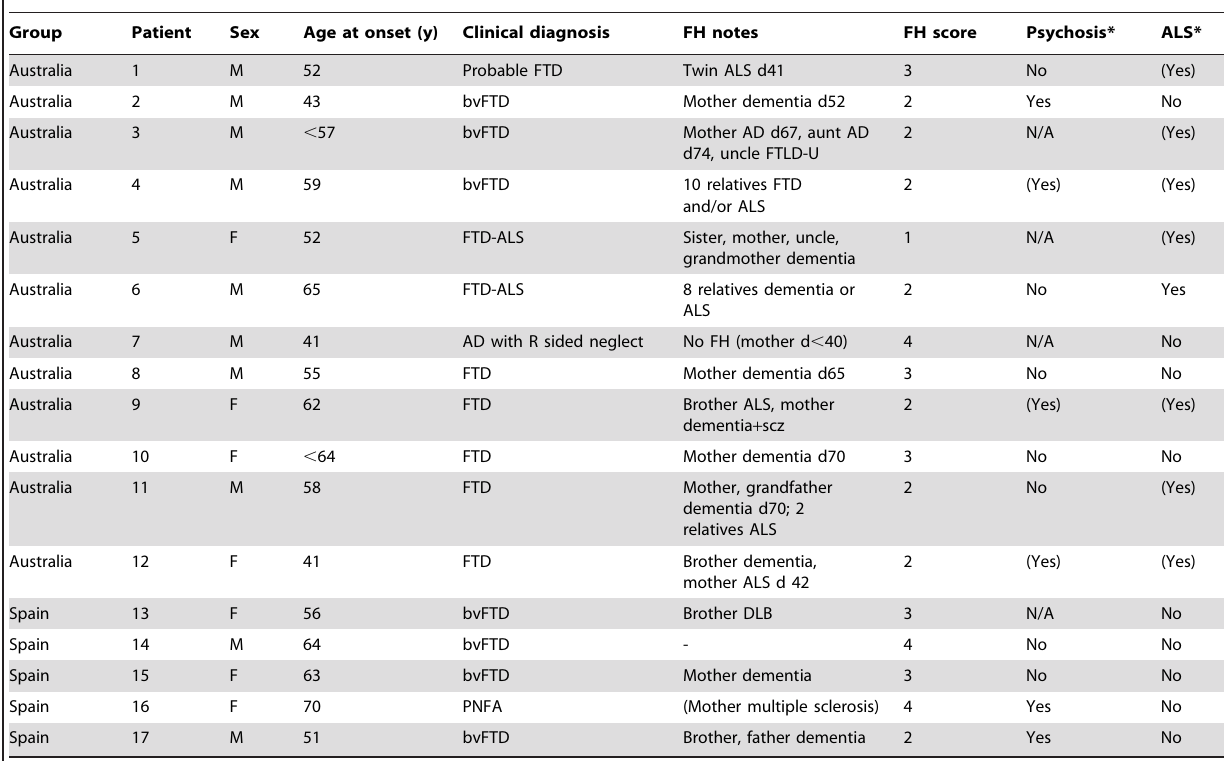
Table 2. Disease characteristics of 17 C9ORF72 mutation